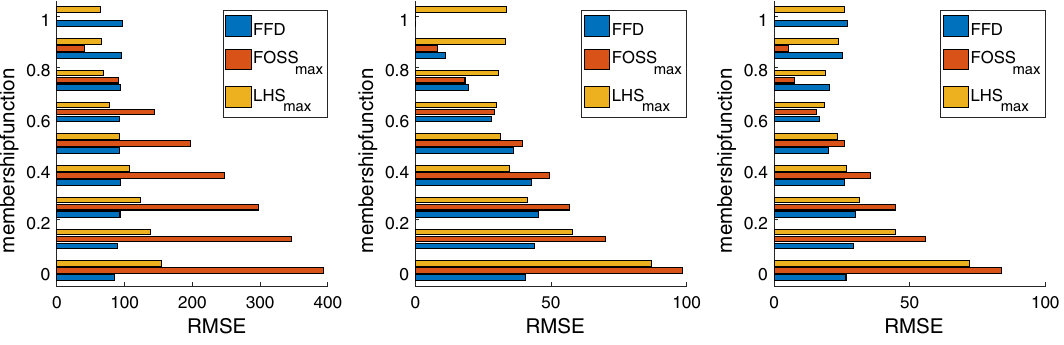
RMSE Fig. 17 Branin function: maximum RMSE on 𝛼 -cuts for a DACE surrogate with 4 (left), 9 (center), and 16 (right) sampling points